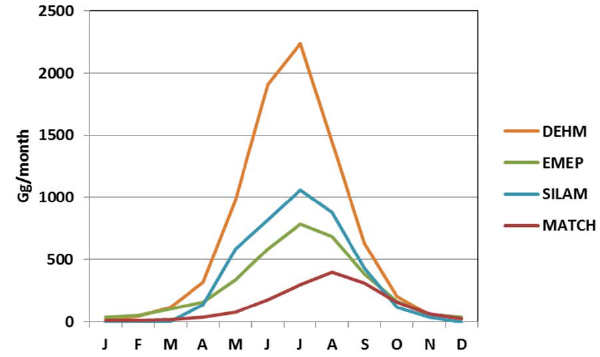
Fig. 3. Simulated seasonal variation in biogenic isoprene emissions as an average for 2000–2009. Units Ggmonth − 1 .